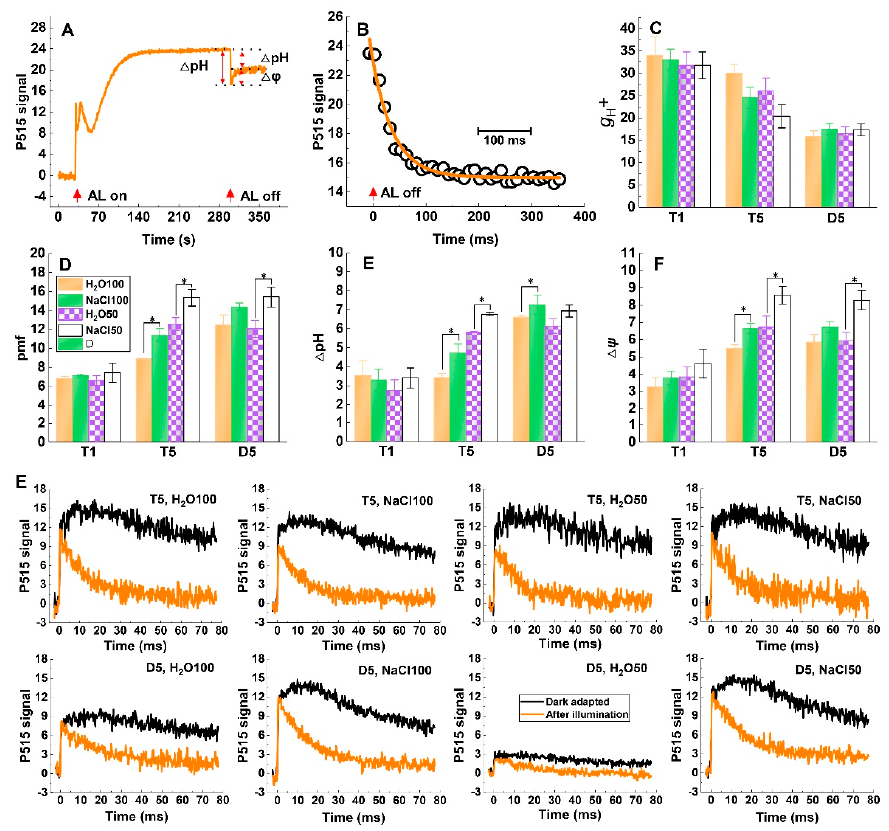
Figure 5. The effect of soil salinity on proton motive force (pmf), thylakoid membrane integrity, and ATP synthase activity of tomato leaves under subsequent drought